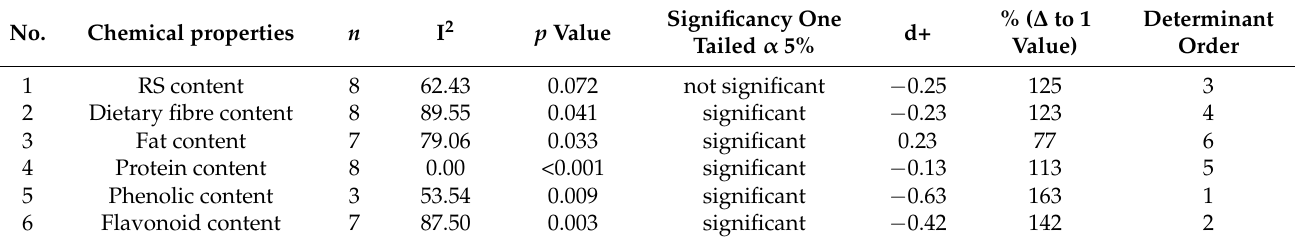
Table 6. Chemical properties of starchy foods determined to affect the GI in in vivo studies with 50 g glucose as the reference food.